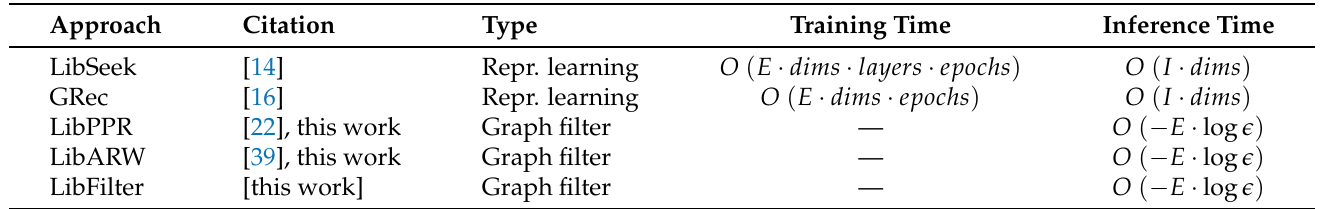
Table 1. Overview of compared library recommendation approaches, including training and inference (for one project) times. Recommendation times are bottlenecked by both training and